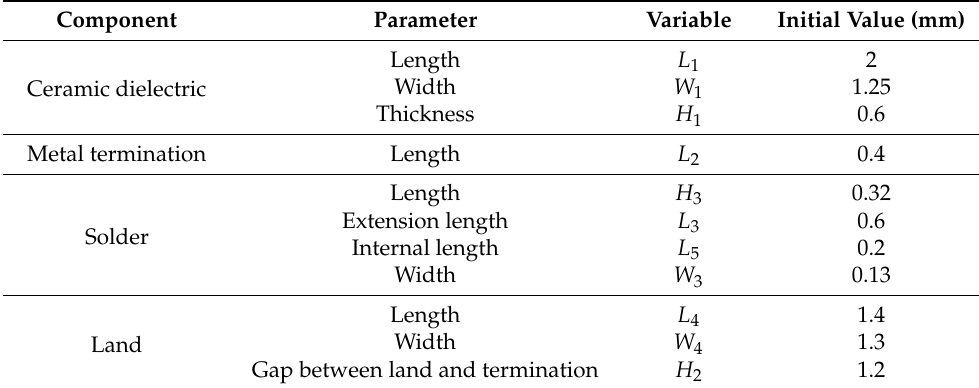
Figure A1. Initial shape of solder joint. ( a ) main view; ( b ) side view. Table A1. Initial parameters set in the surface evolver.